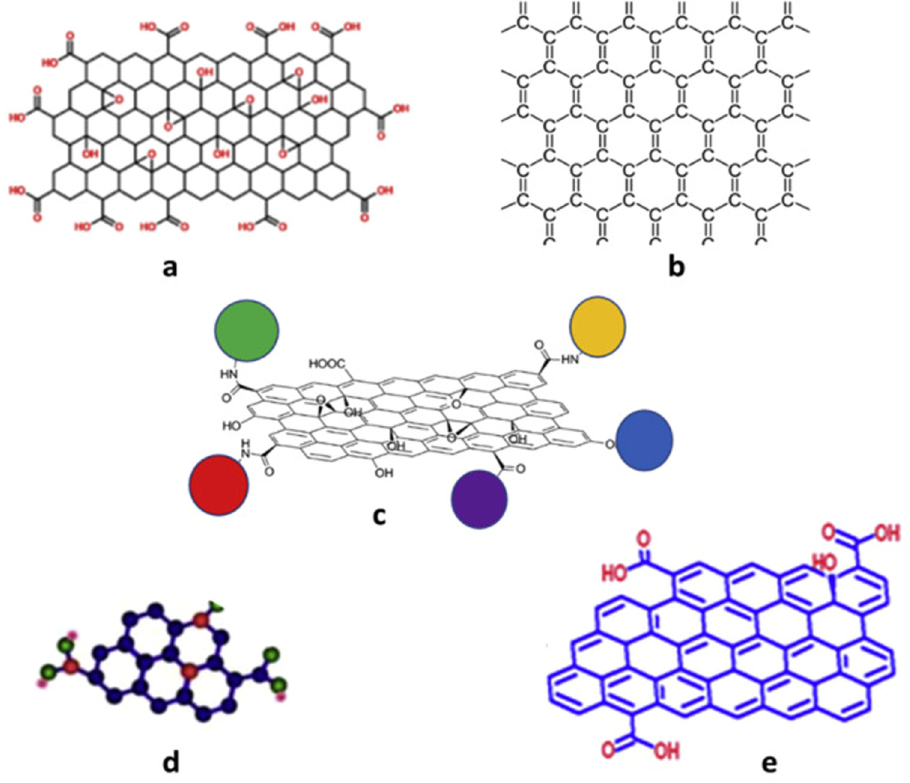
Figure 2: Di ff erent forms of graphene: ( a ) graphene oxide, ( b ) pristine graphene, ( c ) functionalized graphene, ( d ) graphene quantum dot and ( e ) reduced graphene oxide. Reproduced from [ 58 ]